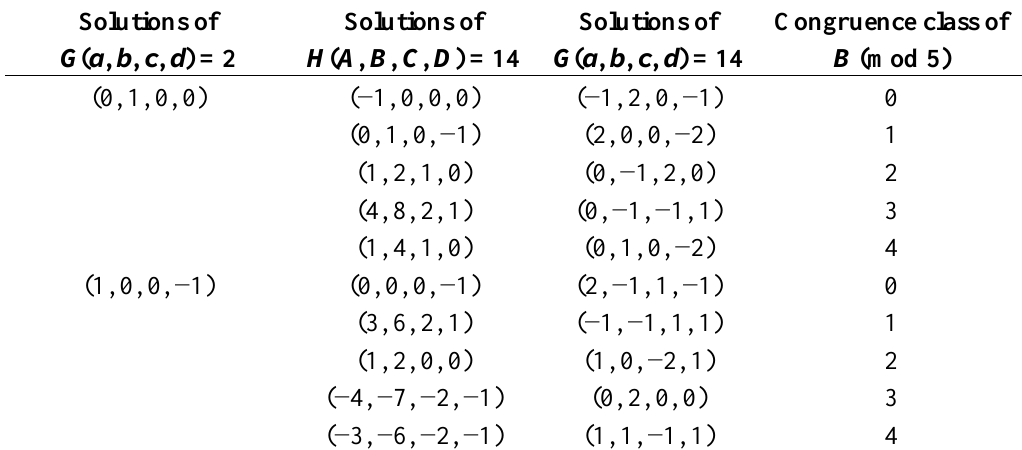
Table 1. Solutions corresponding to 5-cores of 14.